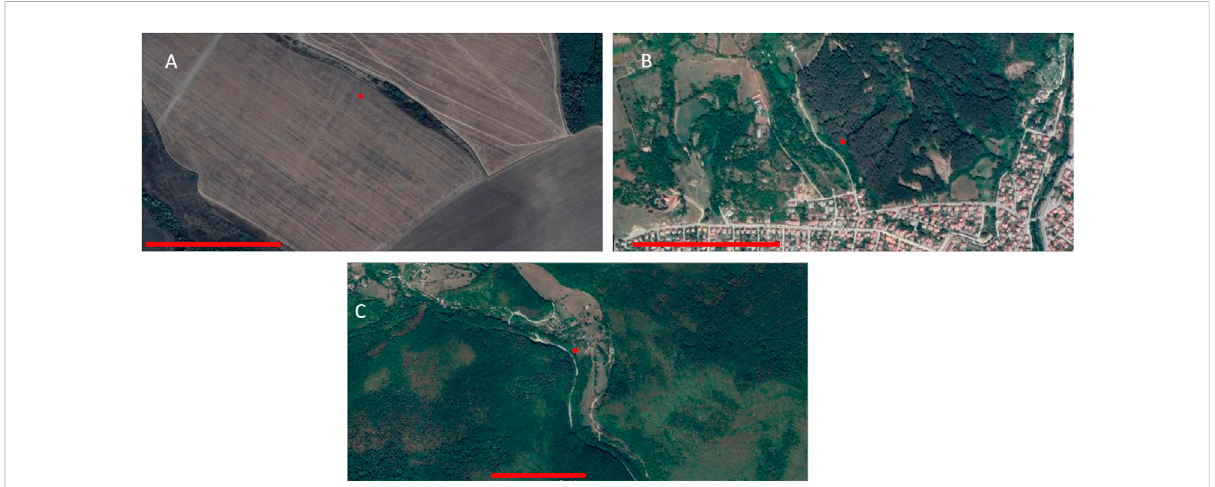
FIGURE 3 Example of sampling sites, as seen using satellite imagery (Map data: Google Maps 2022, Maxar Technologies). A set of sites in Bulgaria: (A) showsanareaofintensivefarmland, closetothesouthofDevene,categorisedas ‘ highagriculture ’ ; (B) showsan ‘ intermediate ’ areaofmixed natural and agricultural land, to the west of Etropole, while (C) shows the heavily forested ‘ low agriculture ’ area to the south of Boykovets. Scale bar represents 500